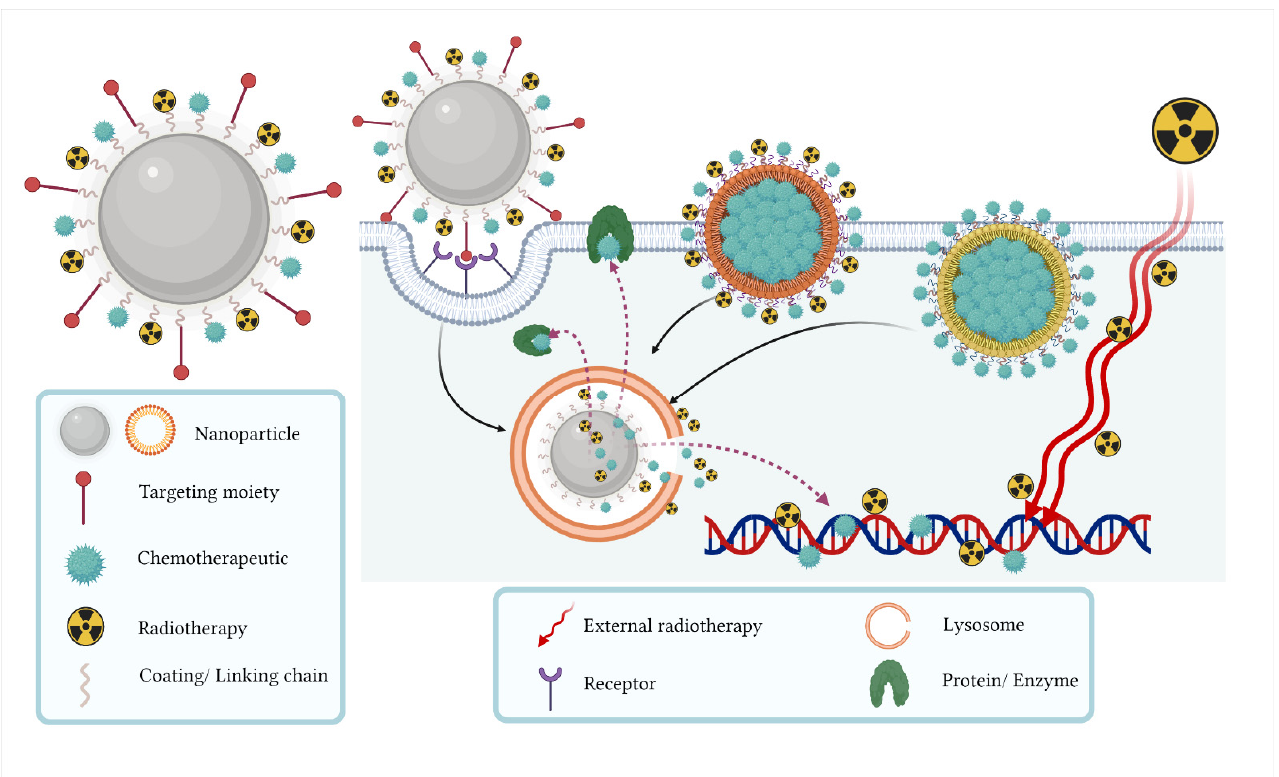
Figure 4. Nanoparticle systems for combined chemoradiotherapy in colorectal cancer. The chemotherapeutic agent can be loaded or conjugated to the nanoparticle and can be carried to the cancer cell through ligands, antibodies, and/or molecular recognition agents that interact with overexpressed proteins in colorectal cancer tumors. The combination with radiation therapy can be through external X-rays or by using radiolabeled